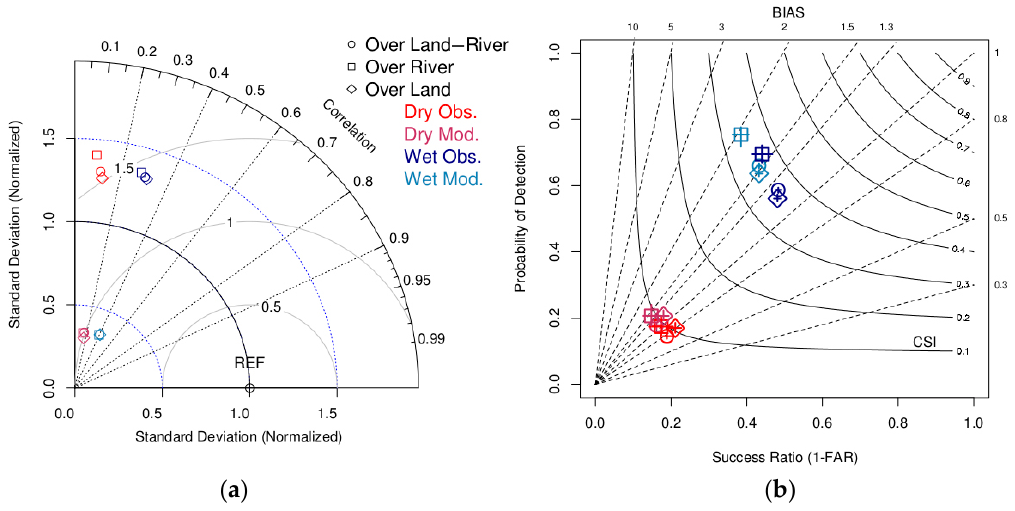
Figure 8. Taylor diagram ( a ) and performance diagram ( b ) showing dry and wet metrics of the IMERG original rainfall estimates versus IMERG modeled via the PUSH model, for different surface types over the Manaus region and for the validation period. In ( a ), the angular axes show COR; whereas radial axes (blue lines) show the SD, normalized against the reference; and the centered RMS difference is represented by the solid gray line. In ( b ), dashed lines represent bias scores with labels on the outward extension of the line; the labeled solid contours correspond to CSI; the x- and y-axis represent the SR and POD, respectively; and sampling uncertainty is given by the crosshairs.